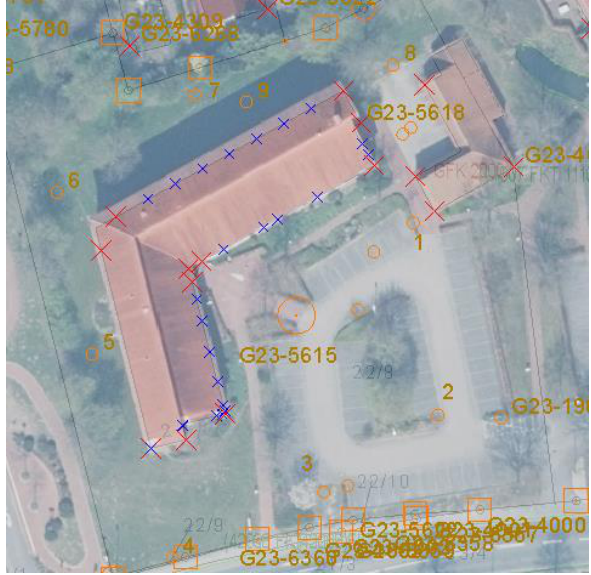
Figure 11. Reference building and location of GCP and CP A total of 12 flights with different flight parameters and settings were carried out which can be compared in various